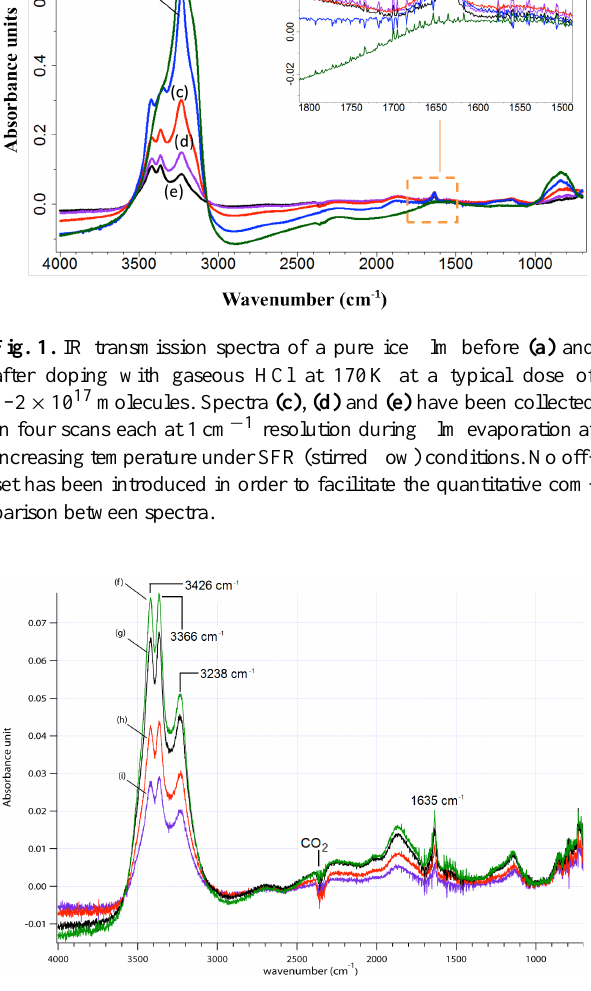
Fig. 2. IR spectra of the same ice–HCl film shown in Fig. 1 at suc- Figure 2. IR spectra of the same ice/HCl film shown in Figure 1 at successive stages during cessive stages during evaporation for 20min at T =187 ± 0.5K un- evaporation for 20 min. evaporation, at T = 187 ± 0.5 K under SFR conditions. No offset has been der SFR conditions. No offset has been introduced.